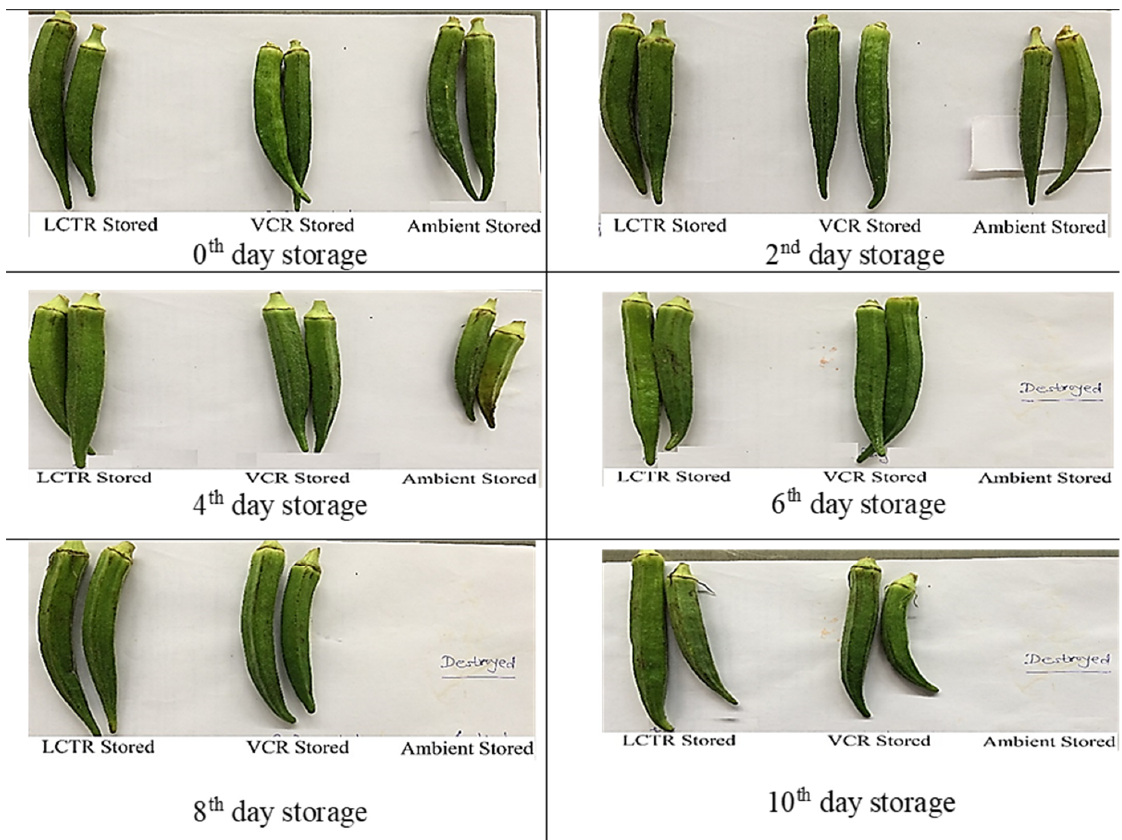
Figure 7. Effect of storage system on the visual appearance of